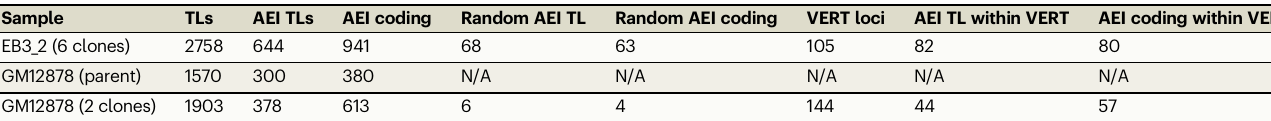
Table 1 | Summary of AEI and VERT